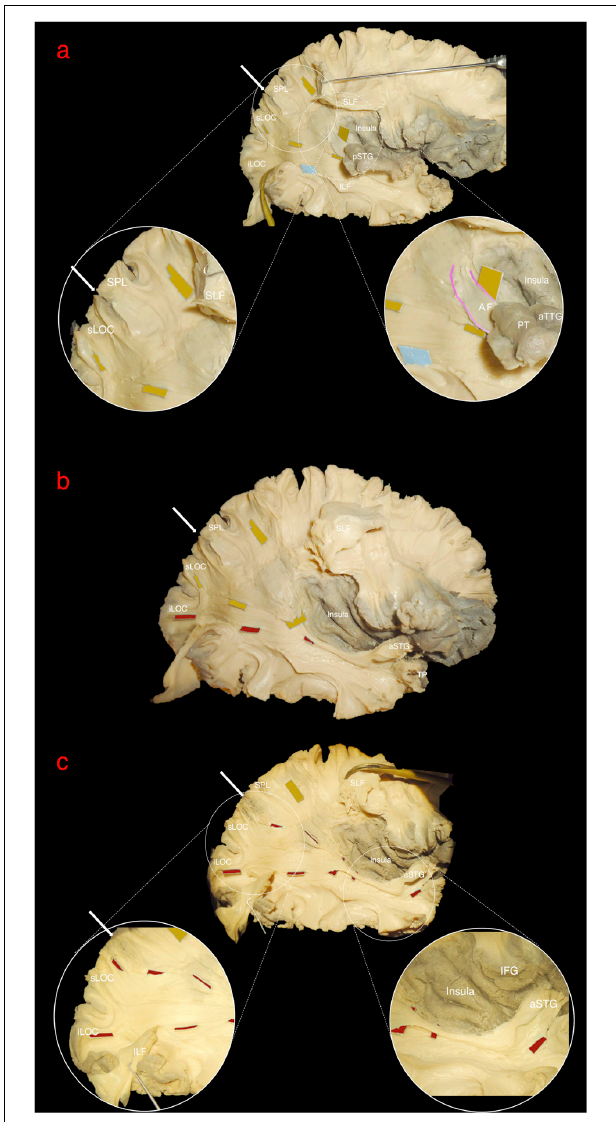
FIGURE 4 | Right hemisphere, lateral view. The white arrow indicates the parieto-occipital sulcus (POS). (a) Superior longitudinal fascicle (SLF) has been sectioned and lifted to uncover the posterior middle longitudinal fascicle (pMdLF, yellow tags) fibers running from posterior superior temporal gyrus (pSTG) to superior parietal lobule (SPL) and superior lateral occipital cortex (sLOC). The inferior longitudinal fascicle (light blue tag) running from temporal pole to inferior lateral occipital cortex (iLOC) is also shown and partially retracted downward. Circles show a magnification of the anterior and posterior terminations of the pMdLF. Anteriorly, a small amount of fibers from planum temporale (PT) and anterior temporal transverse gyrus (aTTG), i.e., the pSTG, join the direct component of the SLF (arcuate fasciculus – AF, pink gradient lines). These fibers are more superficial than pMdLF fibers, which have a more posteriorly oriented direction. (b) vSLF and part of the anterior portion of pMdLF have been removed to show the relationship between the two segments of the MdLF: the pMdLF runs more superficially and cranially than the anterior MdLF (aMdLF, red tags). (c) The pMdLF has been completely removed and the posterior terminations of ILF displaced inferiorly, showing the entire course of the aMdLF from the anterior STG (aSTG) to the sLOC and iLOC. Circles show the magnification of the anterior and posterior terminations of the